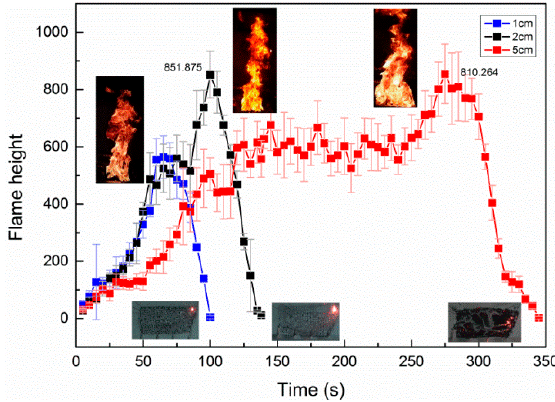
Figure 8. Flame height versus time for the three thickness samples.